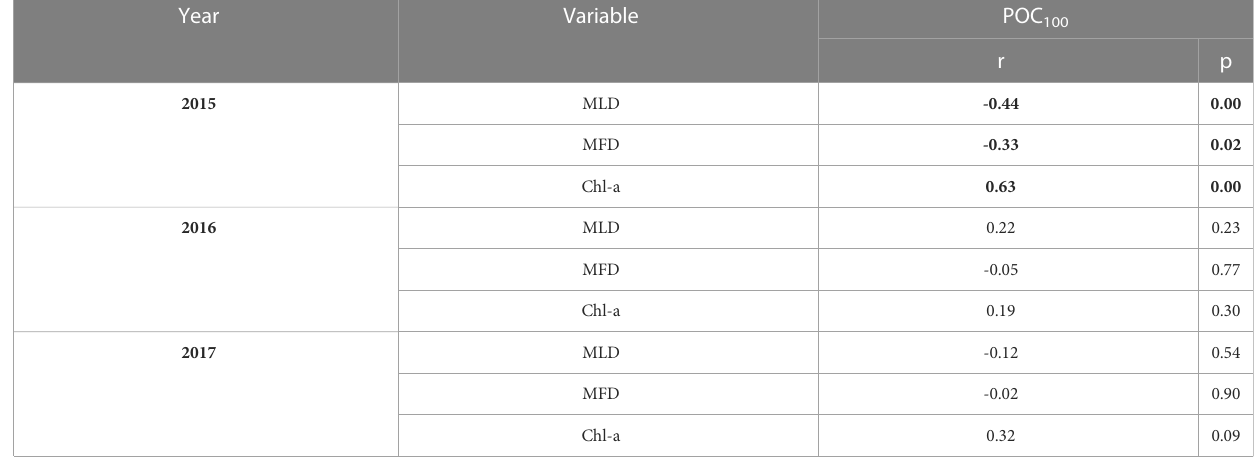
Bold values indicate signi fi cant